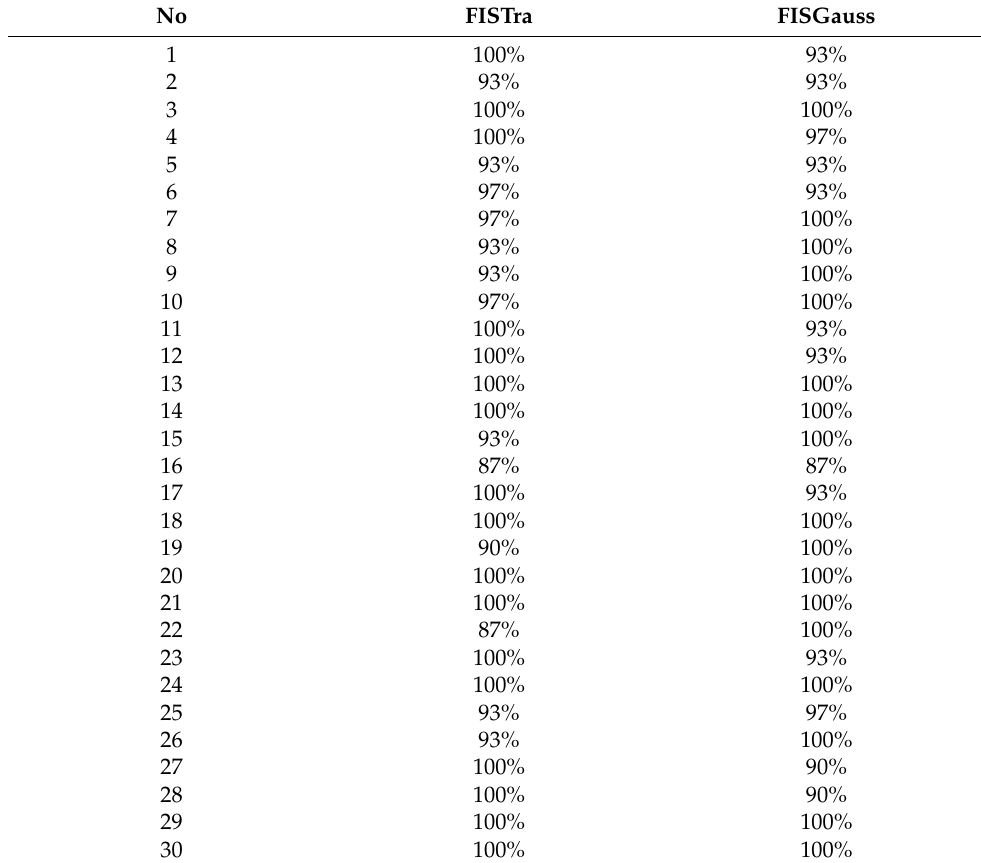
Table 7. Percentage of success in each